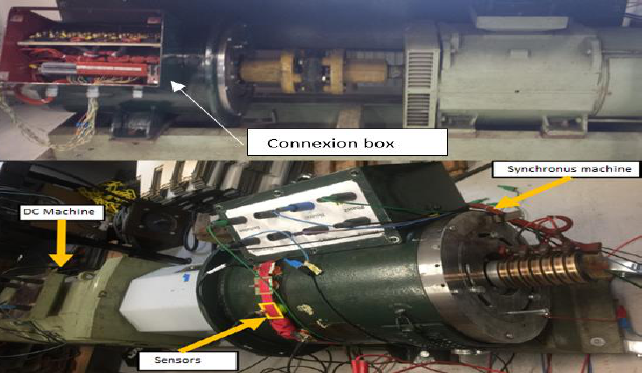
Figure 13. Concentric rotor winding.